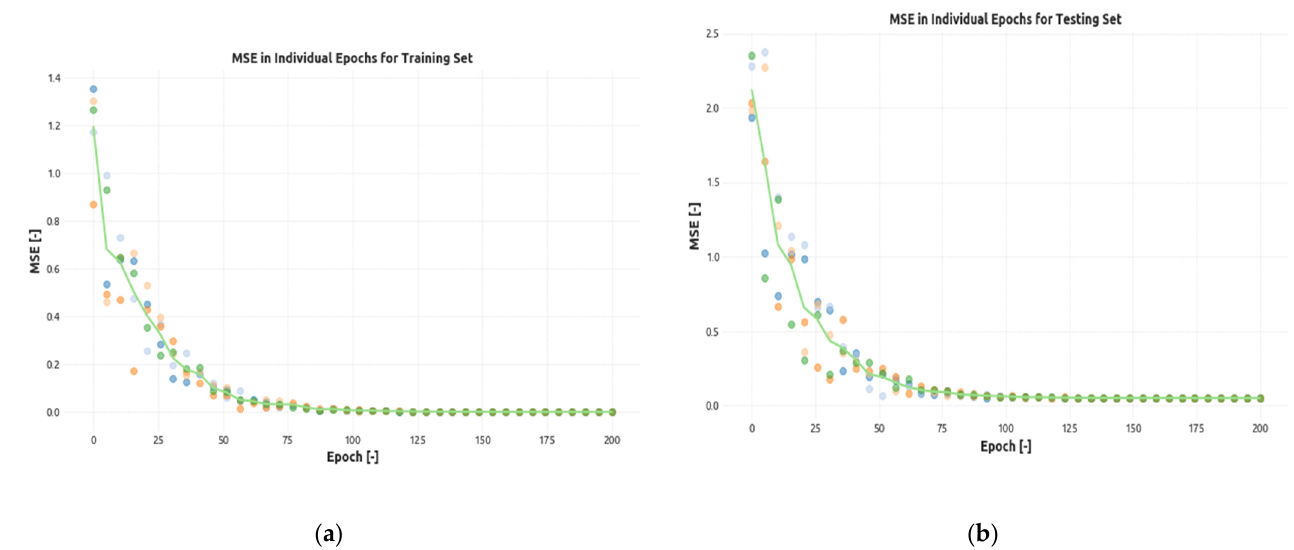
Figure 6. The convergence of the neural network model for both ( a ) training and ( b ) test sets (each experiment was performed five times—individual colors of dots in the charts).